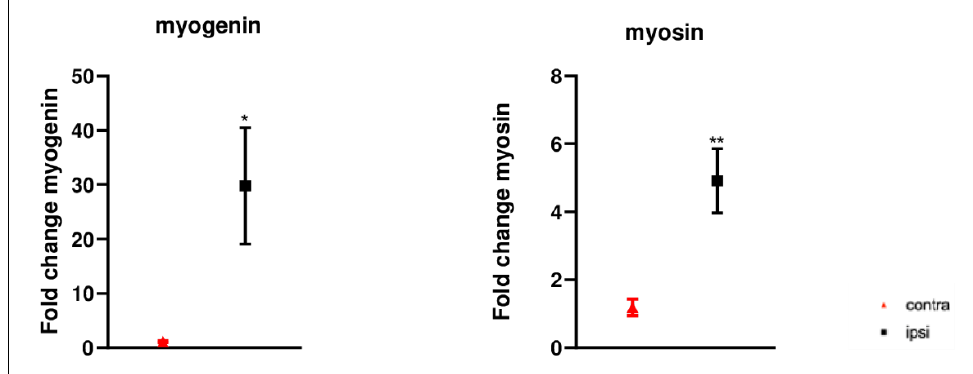
Figure 10. Results of real-time PCR. Myogenin and Myosin gene expression was higher in ipsilateral gastrocnemius muscle after chronic constriction injury compared to that of the contralateral. Results are presented as fold change. *: p < 0.05 vs. contra; **: p < 0.01 vs. contra. Fold change values were calculated as 2 ΔΔCt .